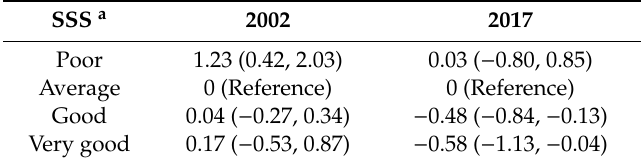
Table 2. Crude association between SSS a and BMI b in 15–16-year-old adolescents. SSS a 2002 2017 Poor 1.23 (0.42, 2.03) 0.03 ( − 0.80, 0.85) Average 0 (Reference) 0 (Reference) Good 0.04 ( − 0.27, 0.34) − 0.48 ( − 0.84, − 0.13) Very good 0.17 ( − 0.53, 0.87) − 0.58 ( − 1.13, − 0.04)